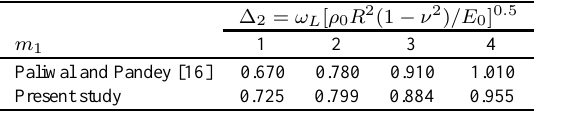
Table 1 Comparing the results obtained in [16] (the lowest eigen- frequency ∆ 2 ) with the dimensionless frequency parameter when the effect of elastic foundation is taken into considera- tion ( m 1 = mπR/L , n = 2 , k 1 = 0 . 5 , h 1 /R = 0 . 002 , ν = 0 . 3 )